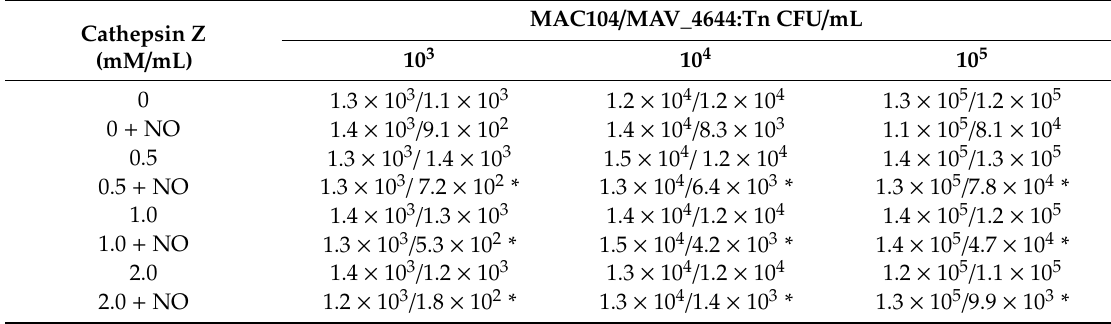
Table 4. In vitro e ff ects of the recombinant cathepsin Z protein on MAH with or without nitric oxide presence. Cathepsin